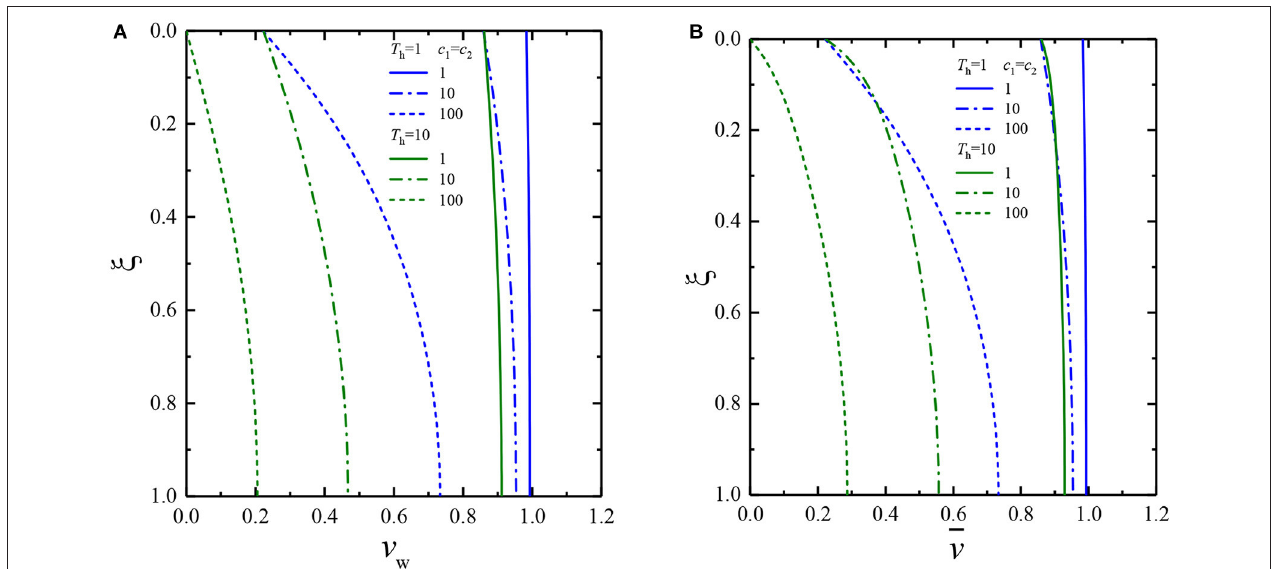
FIGURE 8 | Dissipation of pore-water pressure at any depth when c 1